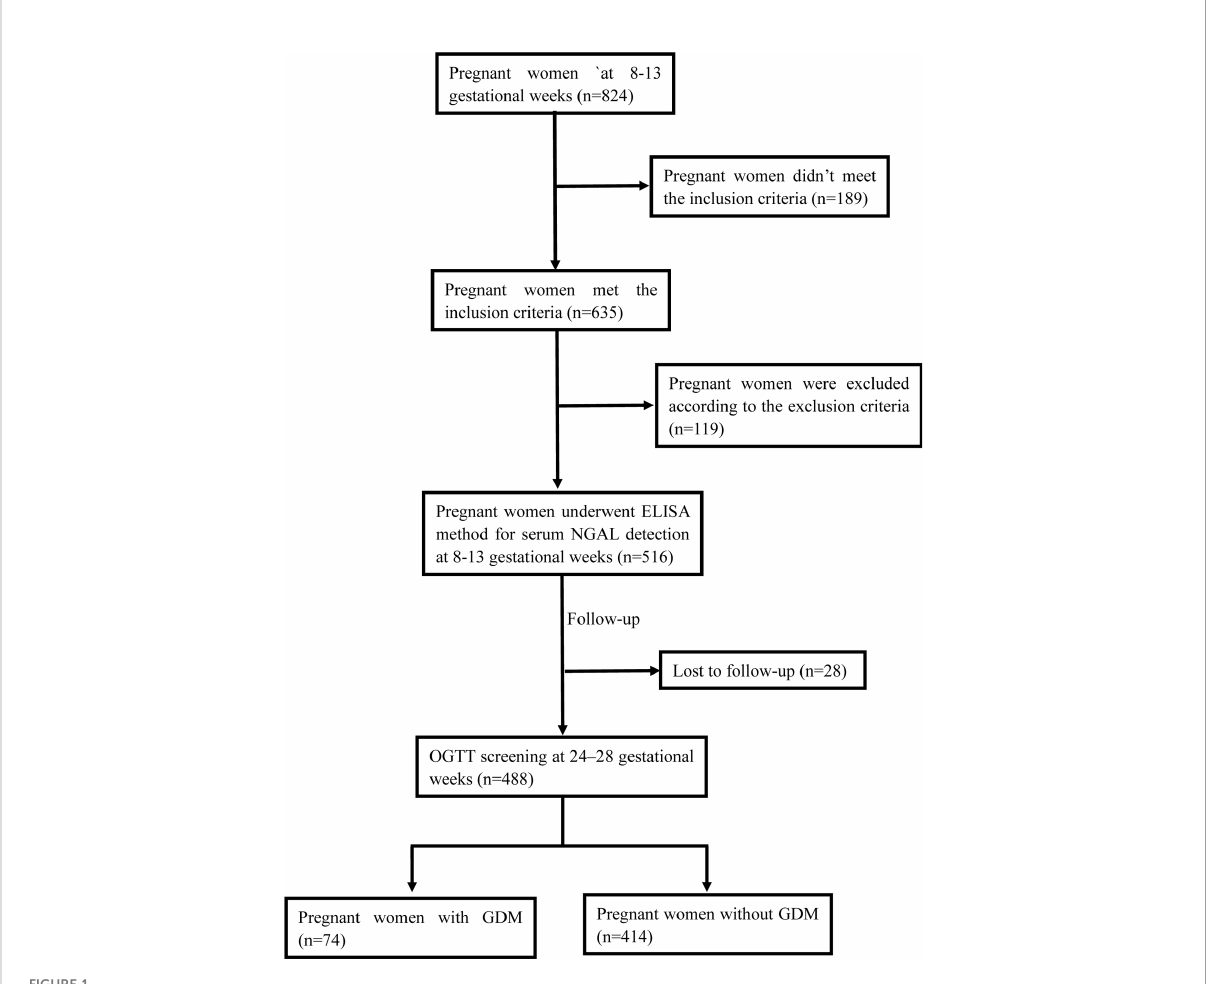
FIGURE 1 Flow graph of the study